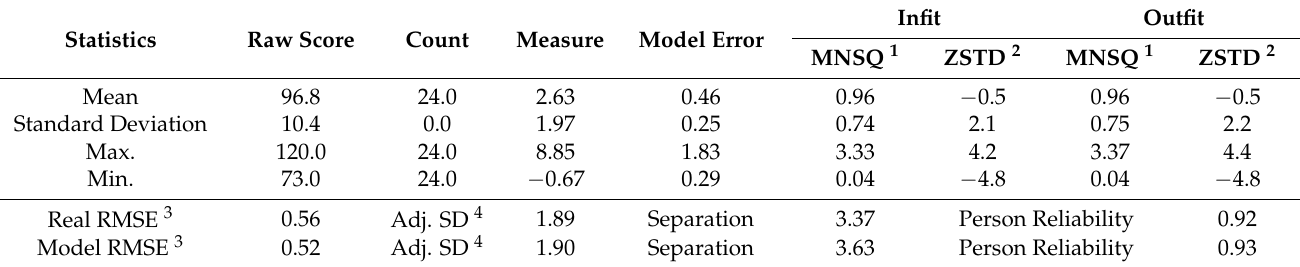
Table 8. Statistical summary of individuals (self-efficacy).